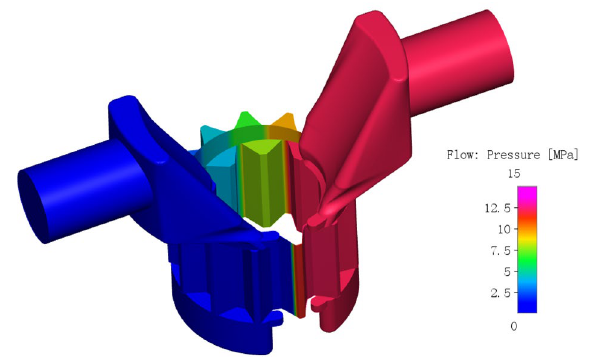
Figure 11. The pressure distribution of the internal flow field of the gear pump.